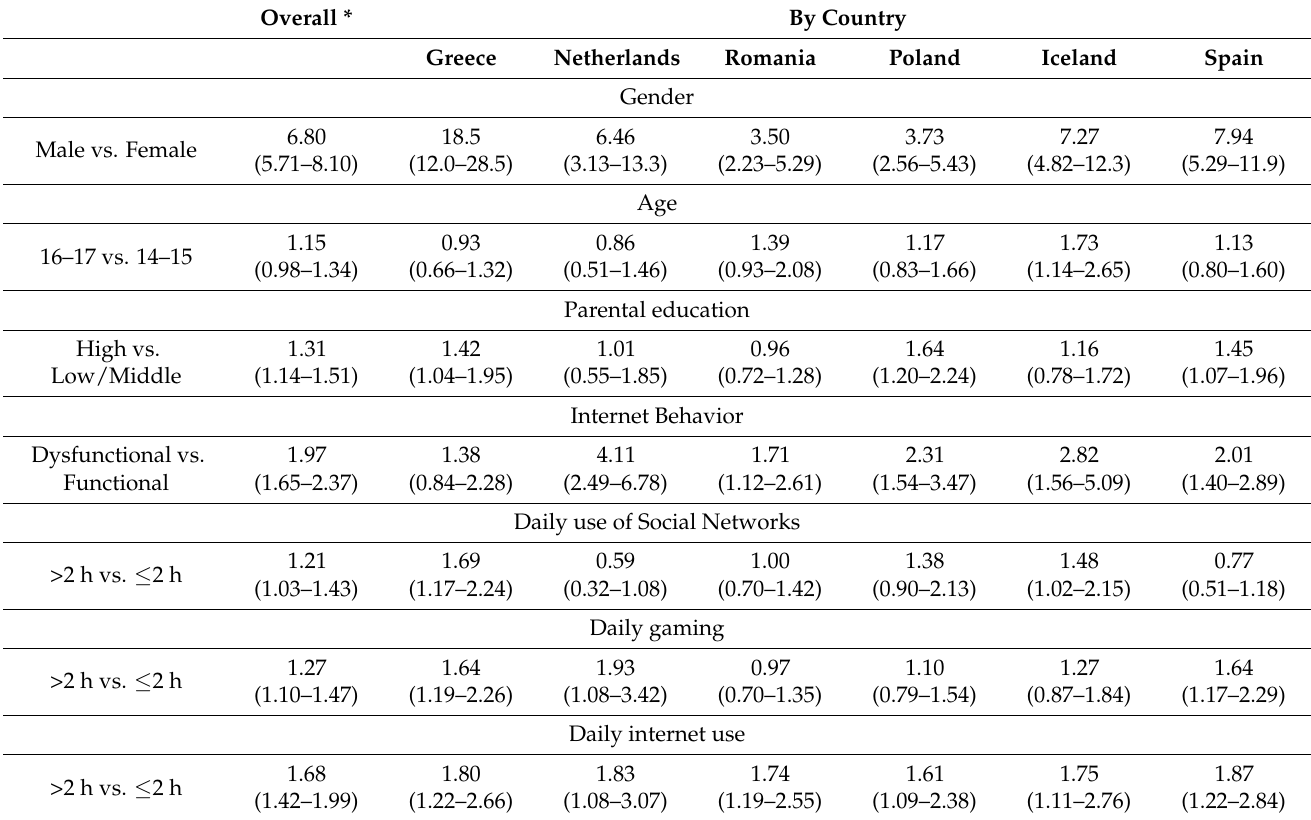
Table 3. Results of logistic regression analyses for frequent use of pornography in the last 12 months. Table shows odds ratios (adjusted for the other explanatory variables included in the analysis) with 95% confidence intervals.